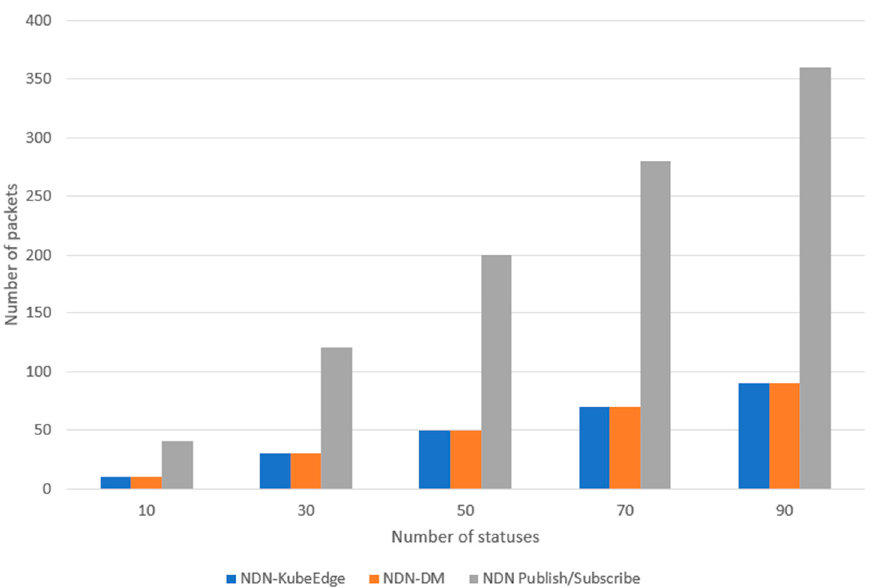
Figure 17. Number of transmitted packets to synchronize status between cloud and devices comparison between our system versus NDN Publish/Subscribe framework and NDN-DM.